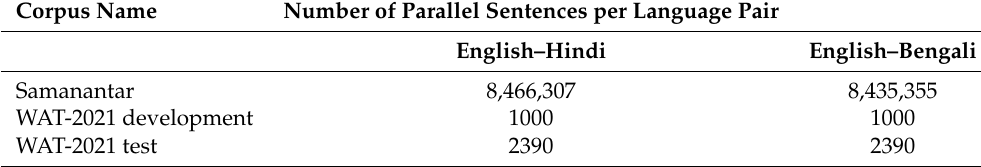
Table 1. Corpus statistics for training, development and